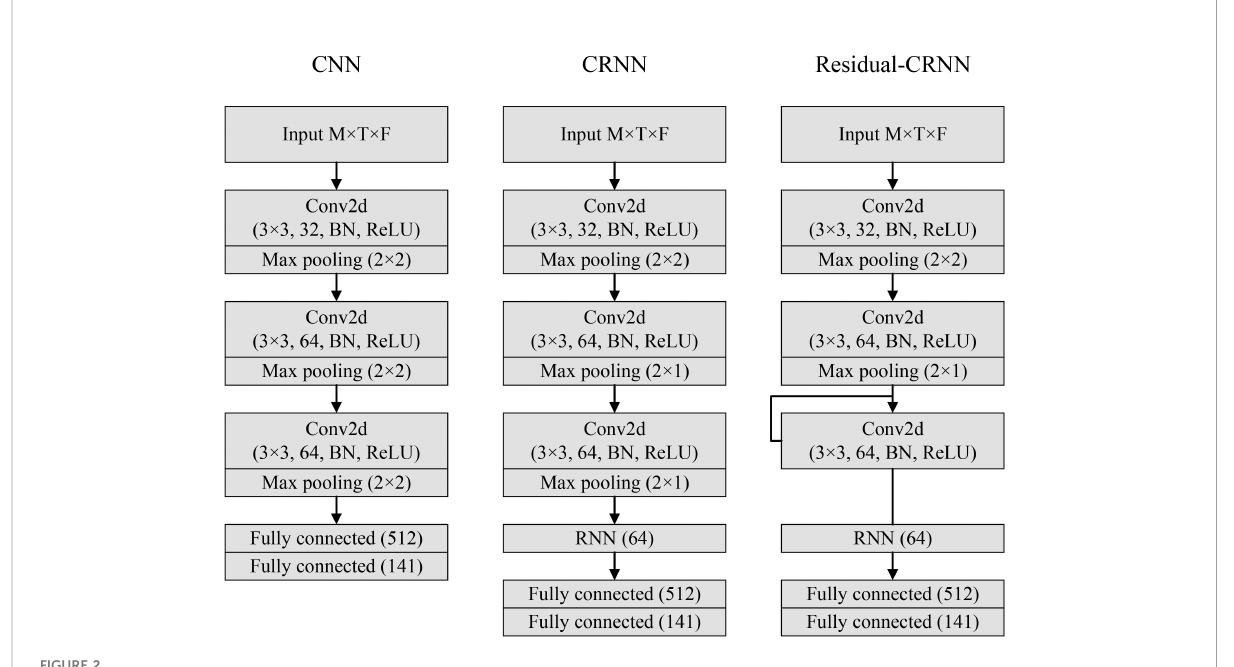
FIGURE 2 Three different architectures of the proposed networks.